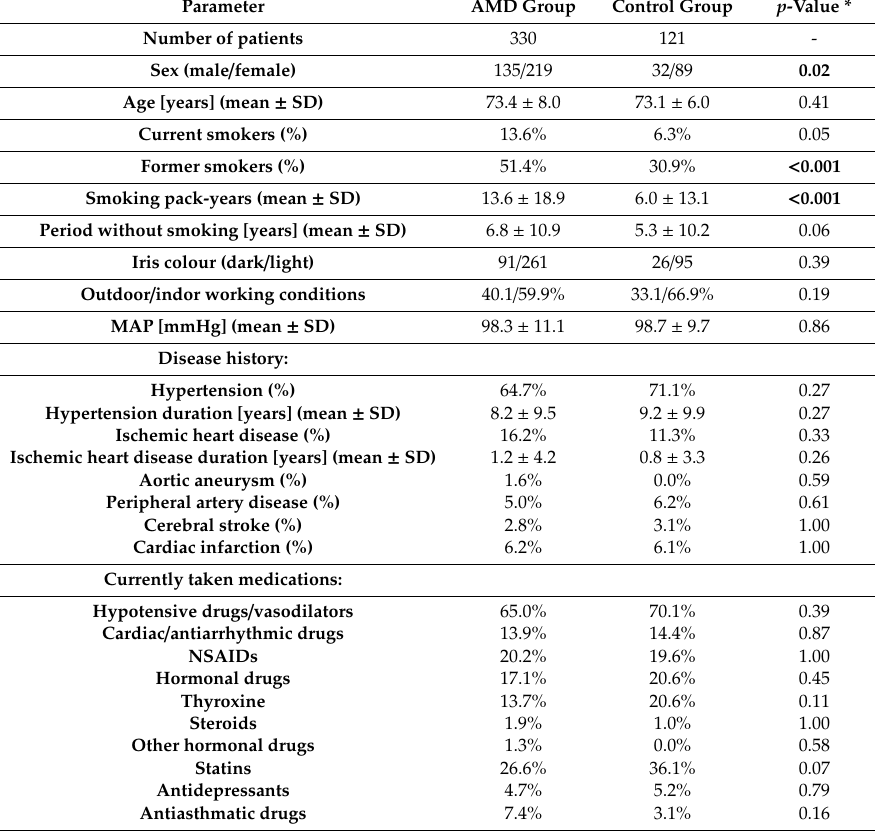
Table 1. Characteristics of the study groups. In bold, p -value < 0.05, which was considered statistically